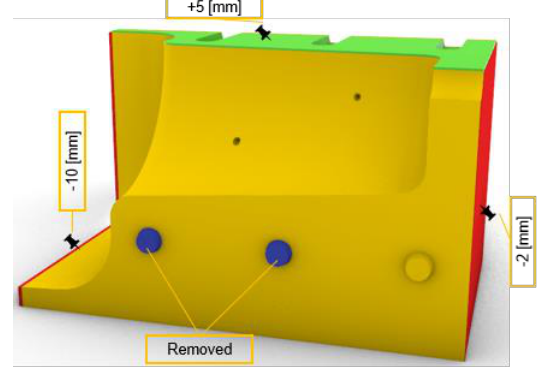
Figure 3 . Modified object in yellow. Red refers to subtraction, green refers to addition, blue parts are